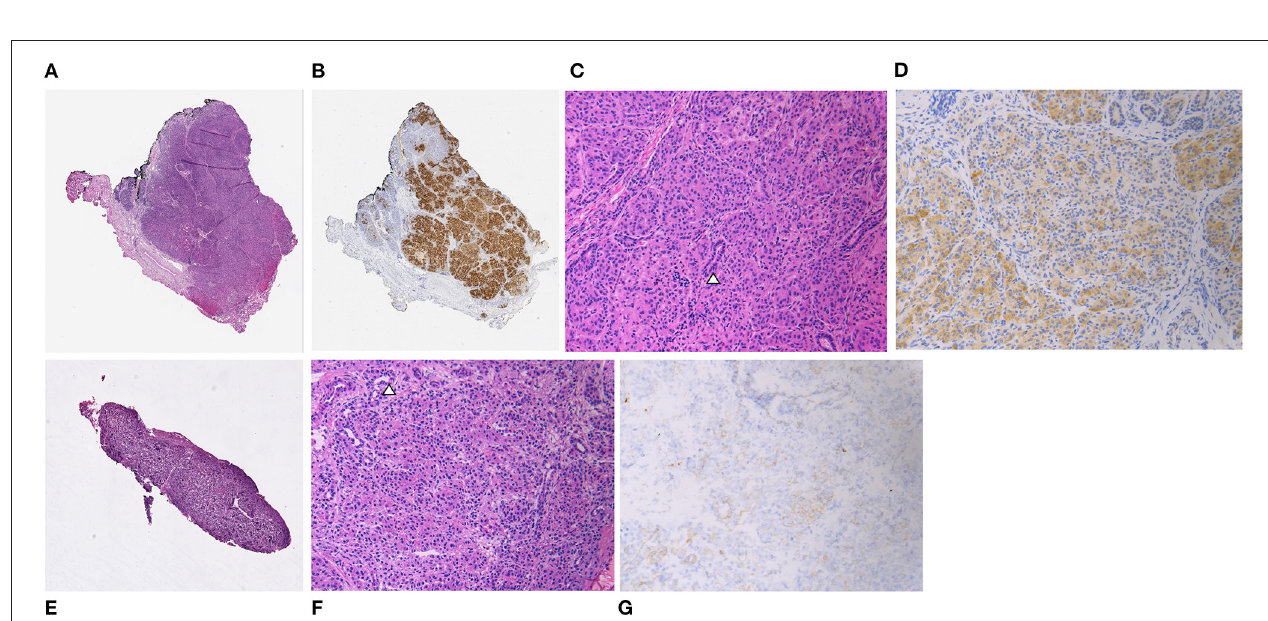
FIGURE 1 | A focal lesion within the pancreatic head/uncinate region ( + ) is visualized on 3D-MIP image (A) and fused PET/CT image (B) in patient 1. Two focal lesions are identified in patient 2 (C–F) . 3D-MIP image at 50min (C) shows one lesion in the pancreatic head ( + ) and the other in the proximal pancreatic tail. Fused PET/CT image (D) shows the focal lesion in the pancreatic head ( + ). Rotated 3D-MIP image (E) permits better visualization of the proximal tail lesion ( + ), which is shown on fused PET/CT image (F) to be exophytic along posterior margin of pancreas. High uptake in the kidneys and bladder is visualized in all images, as expected, due to renal excretion of the radioisotope. Images were originally published in JNM. States LJ, Davis JC, Hamel SM, Becker SA, Zhuang H. Imaging of congenital hyperinsulinism. J Nucl Med. © SNMMI.